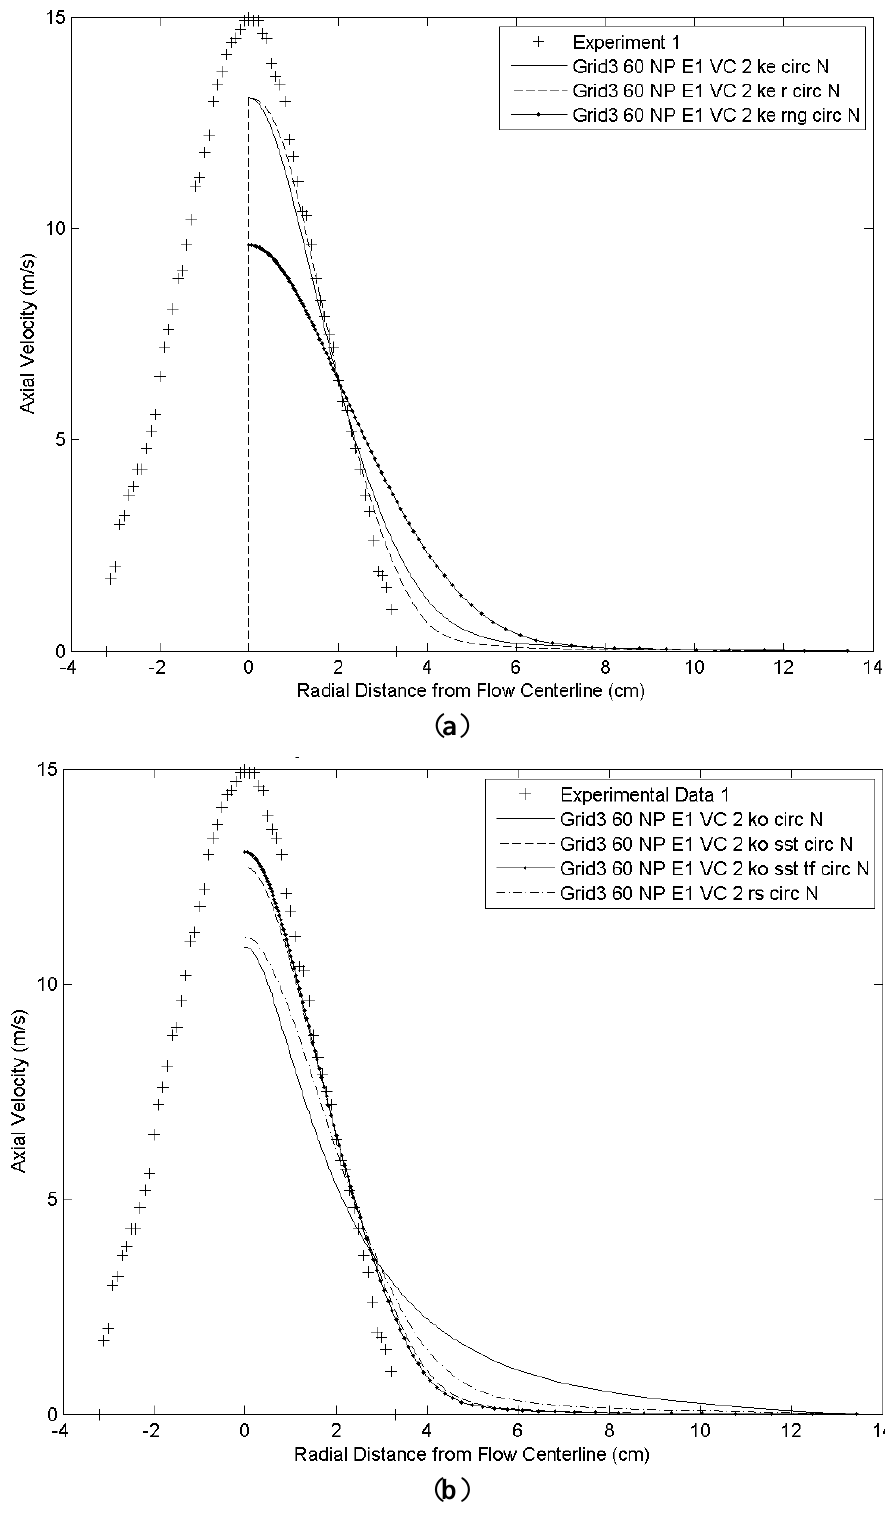
Figure 18. Comparison with experiment of results from ( a ) standard k -  (ke), k -  realizable (ke r) and RNG k -  (ke rng) models at z = 20 cm from the nozzle; ( b ) standard k -ω (ko), k -ω sst (ko sst), k -ω sst tf (ko sst tf) and the Reynolds Stress (rs) models at z = 20 cm from the